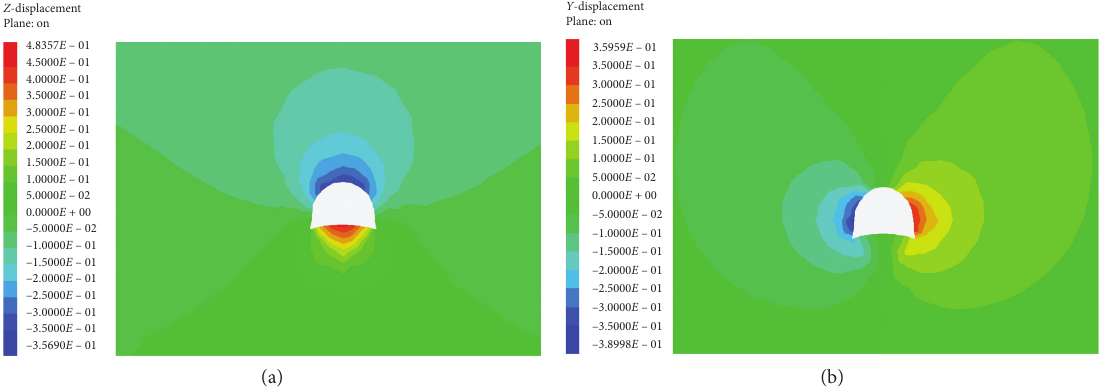
Figure 8: Displacement field distribution of surrounding rock under original support (unit: m): (a) vertical displacement; (b) horizontal displacement.